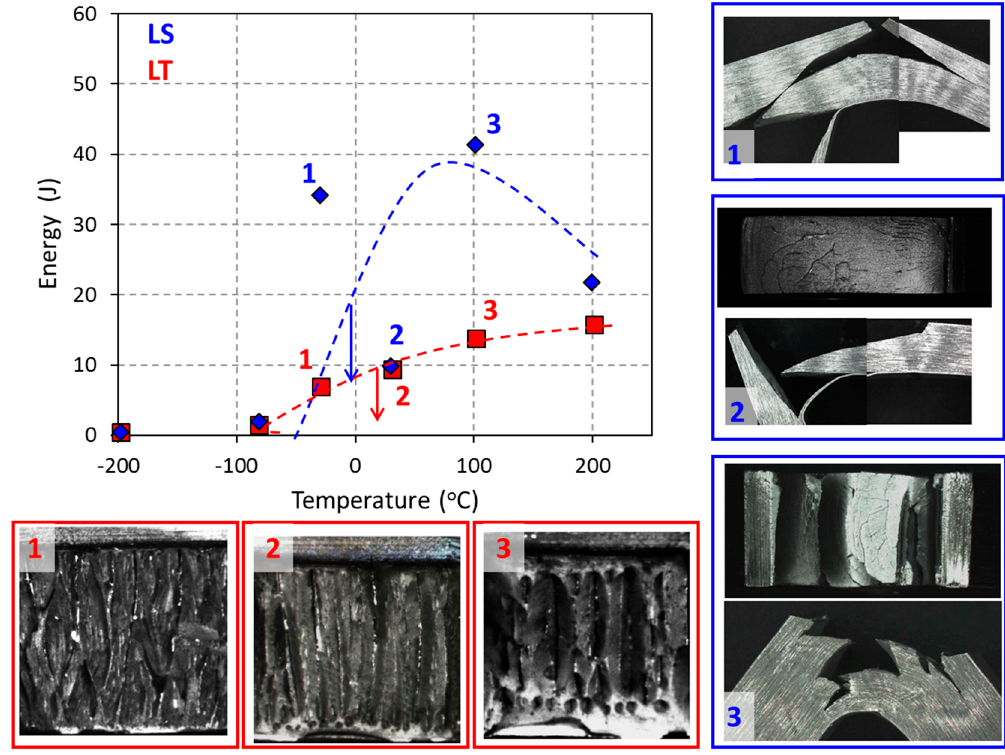
Figure 3. Charpy Impact energy of the PMT samples for LT and LS specimens. The arrows indicate Ductile-brittle transition temperature (DBTT) for LS and LT samples.